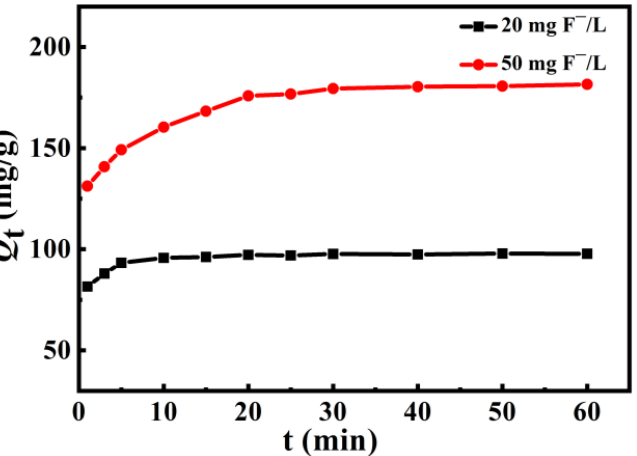
Figure 6. Influence of shaking time and initial F − concentration on defluoridation performance.